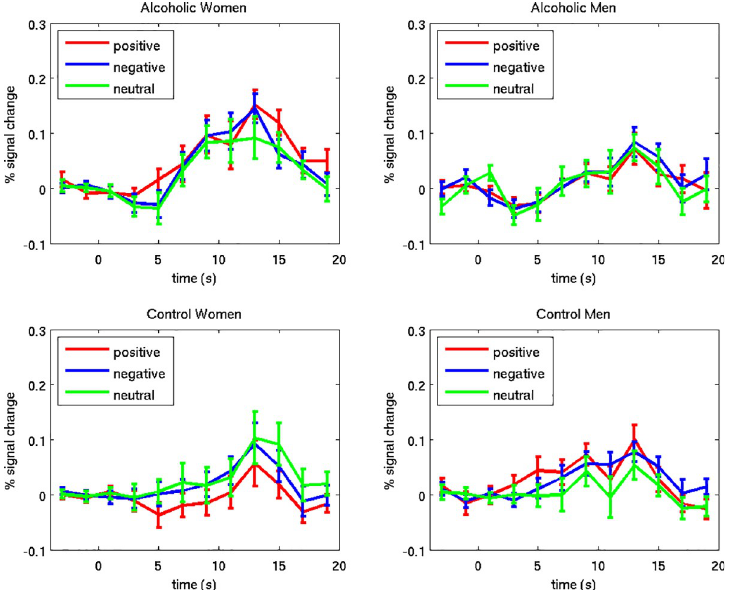
Fig 4. Left hippocampus. Error bars represent standard error of the mean. The percent signal change represents brain activity resulting from presentation of the task stimuli. The analysis window used to examine the encoded faces was 2 to 10 seconds. Brain activity following that period shows responses to the distractor and probe stimuli, to be described in a future research report.